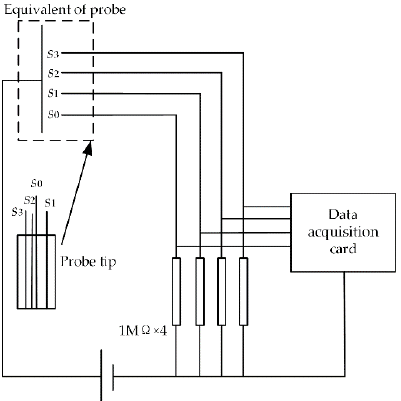
Figure 1. Schematic diagram for the measurement circuit of the four-sensor probe.